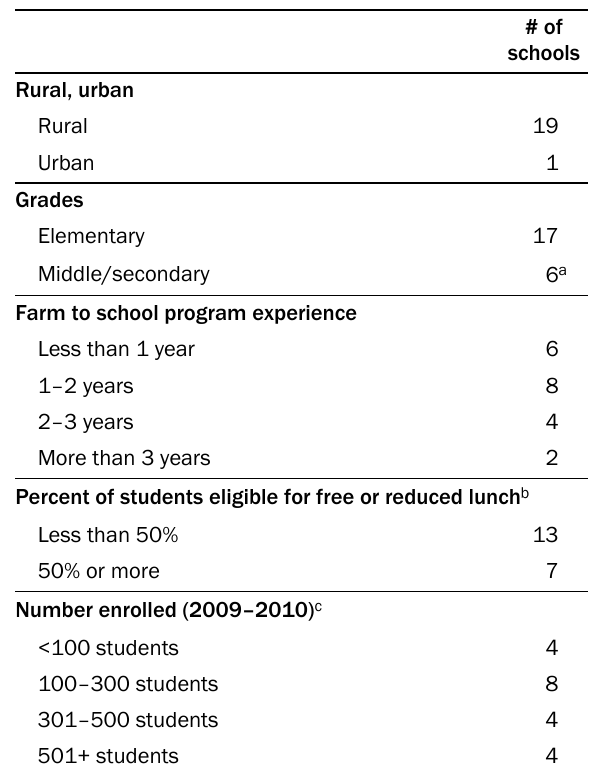
Table 1. Summary of Schools ( N =20)